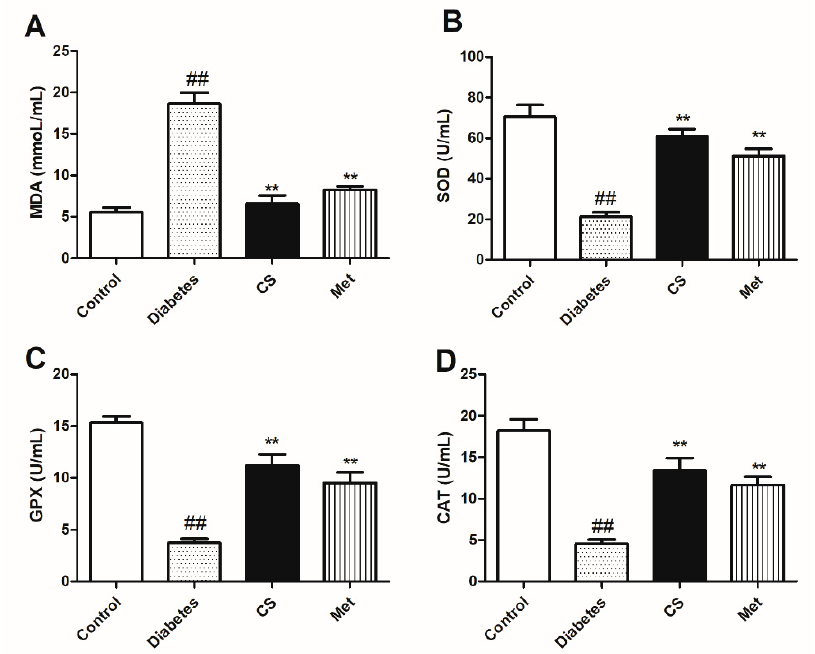
Figure 4. Serum levels of MDA concentration, superoxide dismutase (SOD), glutathione peroxidase (GPX) and catalase (CAT) activities in each group at the end day of the animal experiment. ( A ) serum MDA level in each group; ( B ) serum SOD activity in each group; ( C ) serum GPX activity in each group; ( D ) serum CAT activity in each group. ## p < 0.01 compared with the control group; ** p < 0.01 compared with the diabetic group.